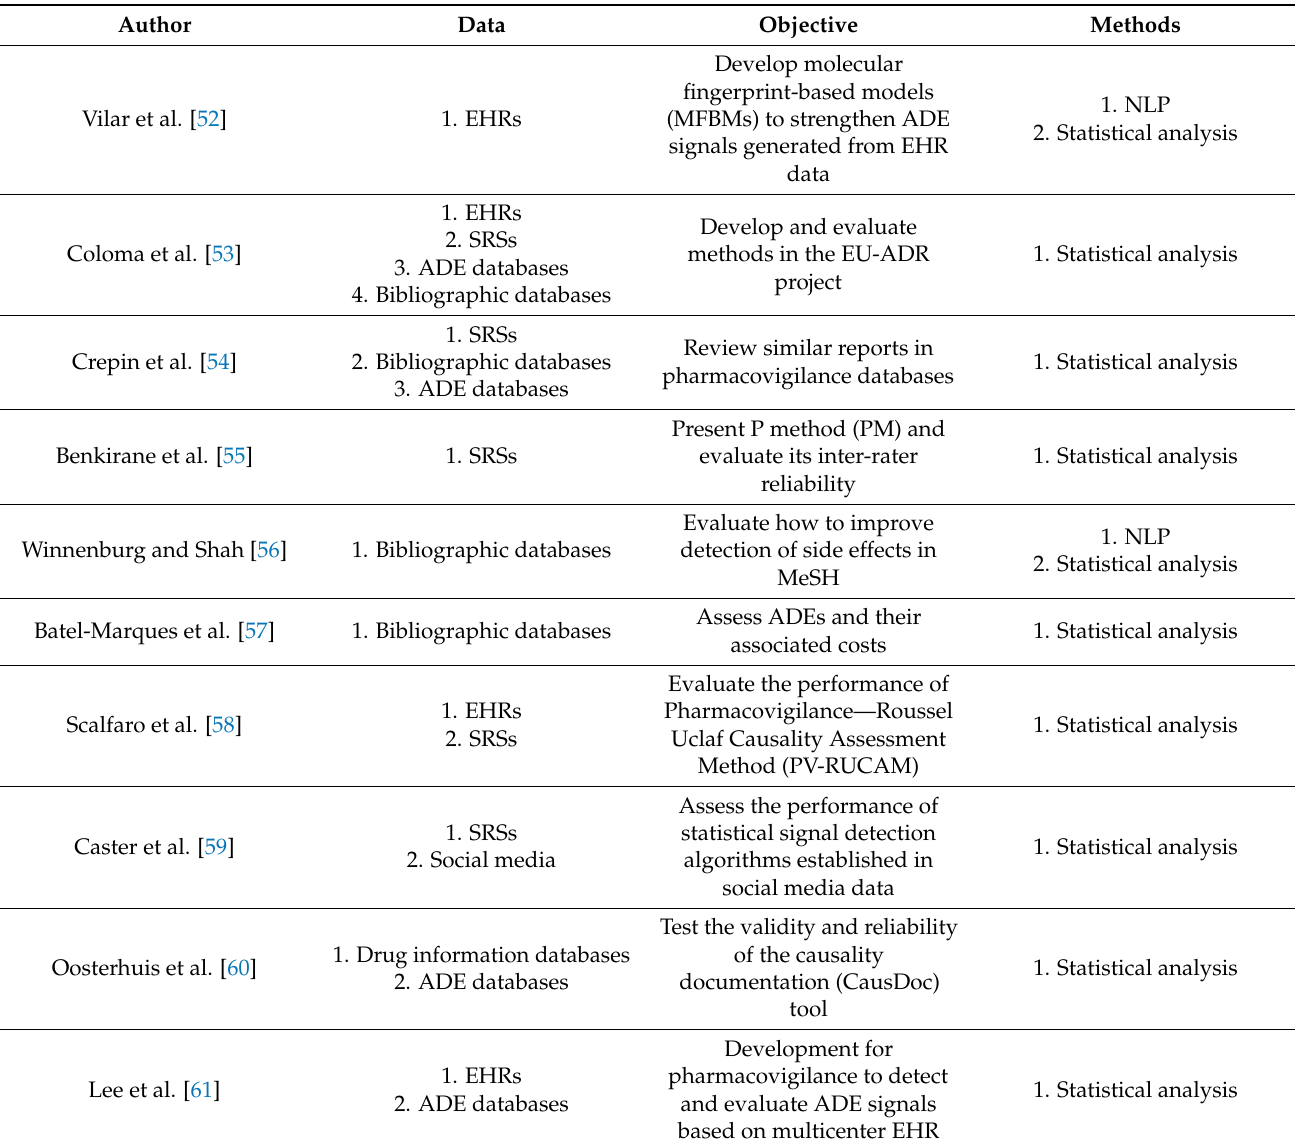
Table 4. List of papers for assessing ADR signals and developing reference